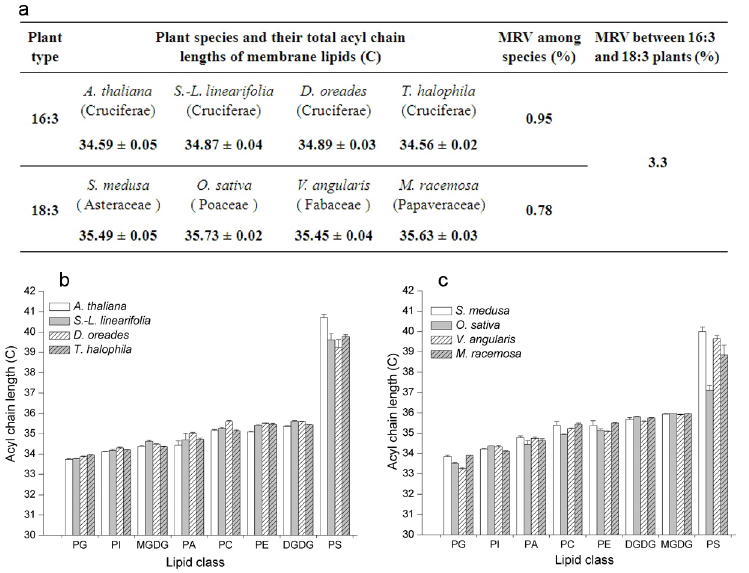
Figure 1. Acyl chain lengths of eight plants. ( a ) Acyl chain lengths of membrane lipids, ( b ) The acyl chain length of membrane glycerolipids of 16:3 plants, or ( c ) The acyl chain length of membrane glycerolipids of 18:3 plants. MRV, maximum relative variation. Values are means 6 s.d. ( n =5).